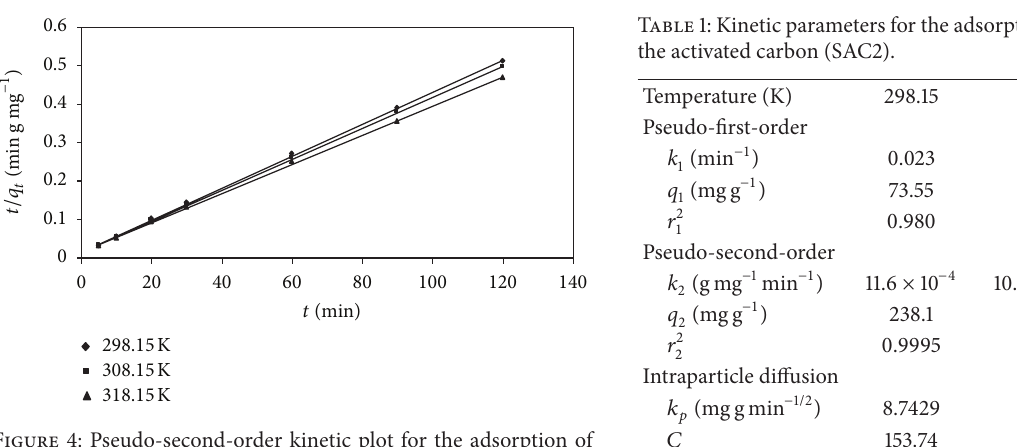
Figure 4: Pseudo-second-order kinetic plot for the adsorption of lead (II) ions onto the activated carbon (SAC2).